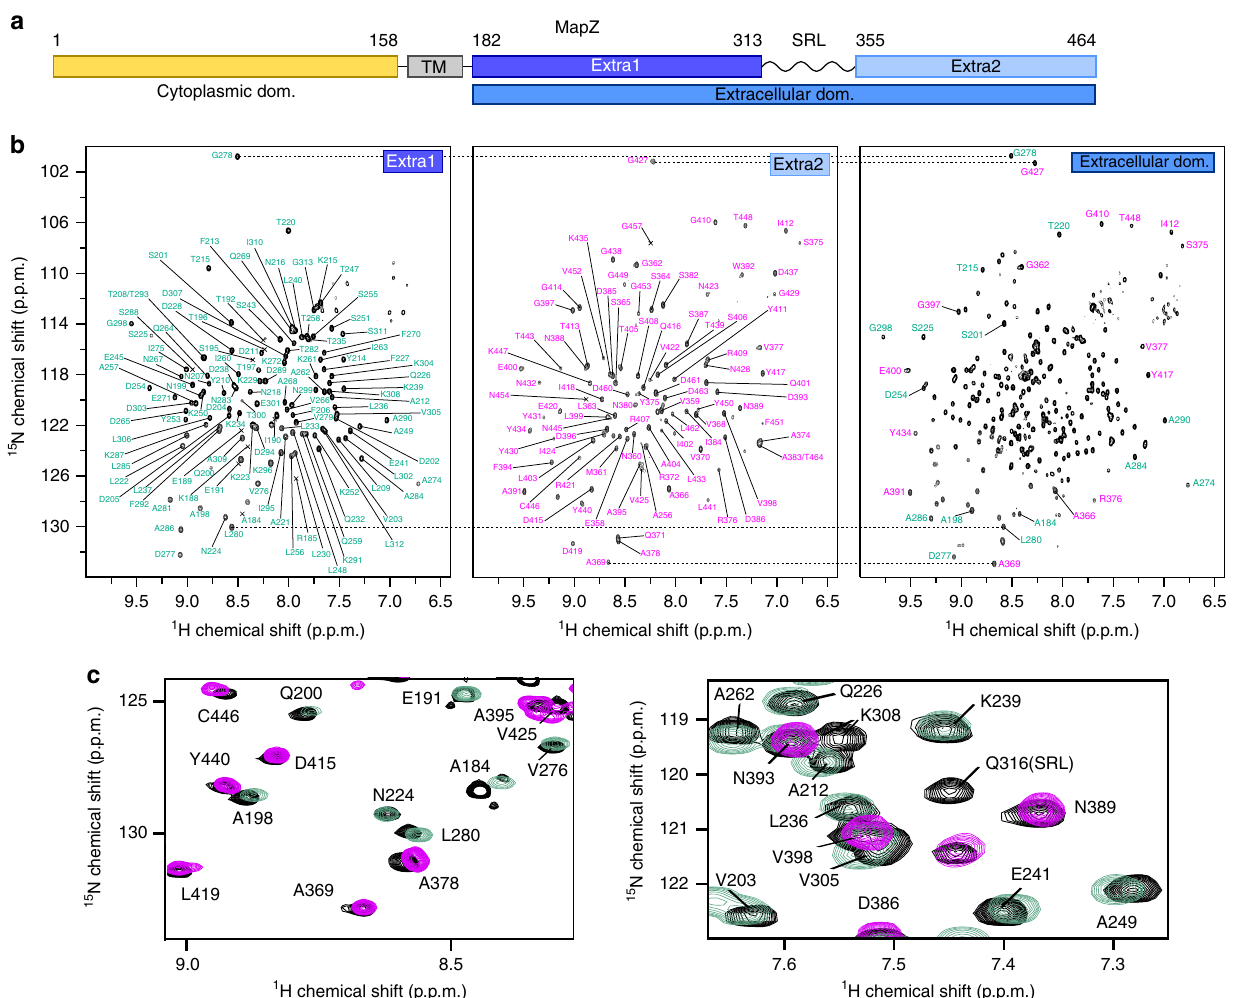
Figure 1 | Organization of MapZ and NMR characterization of its extracellular domain. ( a ) Architecture of MapZ. MapZ is composed of a cytoplasmic (in yellow) and an extracellular domain (in blue; residues 1–158 and 182–464, respectively), connected through a transmembrane a -helix (in grey). The extracellular domain of MapZ (MapZ extra ) is predicted by bioinformatic approaches 15 to be divided in two independent subdomains MapZ extra1 (in dark blue) and MapZ extra2 (in pale blue) linked by a flexible serine-rich stretch (from residues 314–354). MapZ extra1 and MapZ extra2 extend from residues 182–313 and 355–464, respectively. ( b ) 2D-[ 1 H, 15 N]-BEST-TROSY of MapZ extra1 (left), MapZ extra2 (middle) and MapZ extra (right). Assignment of the resonances of the MapZ extra1 and MapZ extra2 subdomains is displayed in turquoise and magenta, respectively. A full resonance assignment of the MapZ extra spectrum is reported in Supplementary Fig. 3. ( c ) Excerpts of the superimposition of the 2D-[ 1 H, 15 N]-BEST-TROSY spectra of MapZ extra1 (turquoise), MapZ extra2 (magenta) and MapZ extra (black). Assignments for the full-length construct are reported in black for each of the resonances. They all show a good overlay with resonances of the individual subdomains, with the exception of K308 that is affected due to its location at the C terminus of MapZ extra1 (in the later construct the resonance is superimposed with the resonance in magenta of N393) and of Q316, which is part of the SRL and thus absent from MapZ extra1 or MapZ extra2 . This superimposition highlights the preservation of the fold of the isolated subdomains in the full-length construct, as outlined by dashed lines in b